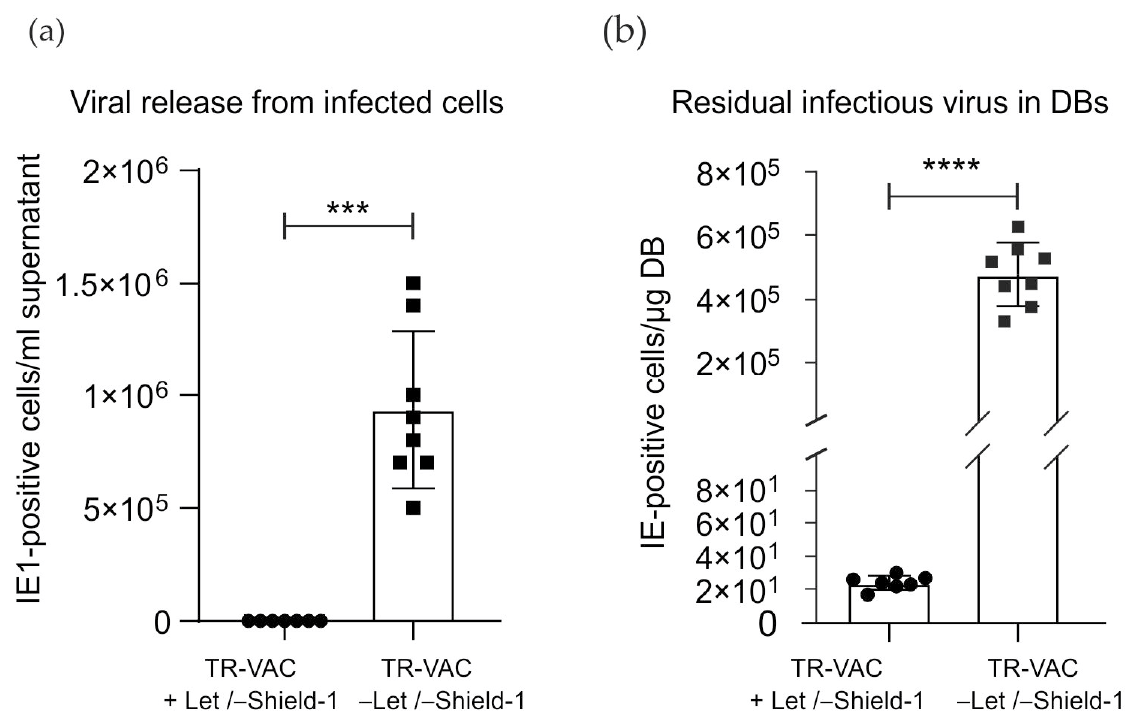
Figure 9. Release of infectious virus from TR-VAC-infected HFF and residual infectious virus in DB preparations. ( a ) Release of infectious virus from TR-VAC-infected cells in the presence or absence of LMV. ( b ) Levels of residual infectious virus in TR-VAC DB, prepared from cultures with or without LMV. The levels of infectious virus in the culture medium ( a ) or DB-preparations ( b ) were measured by serial dilution of the material on HFF indicator cells combined with staining for IE1 and counting of positive nuclei. The assay was performed in the presence of Shield-1 to avoid IE1-degradation ( p value in a: 0.0001, ***; p value in b: < 0.0001,∗∗∗∗ ) .